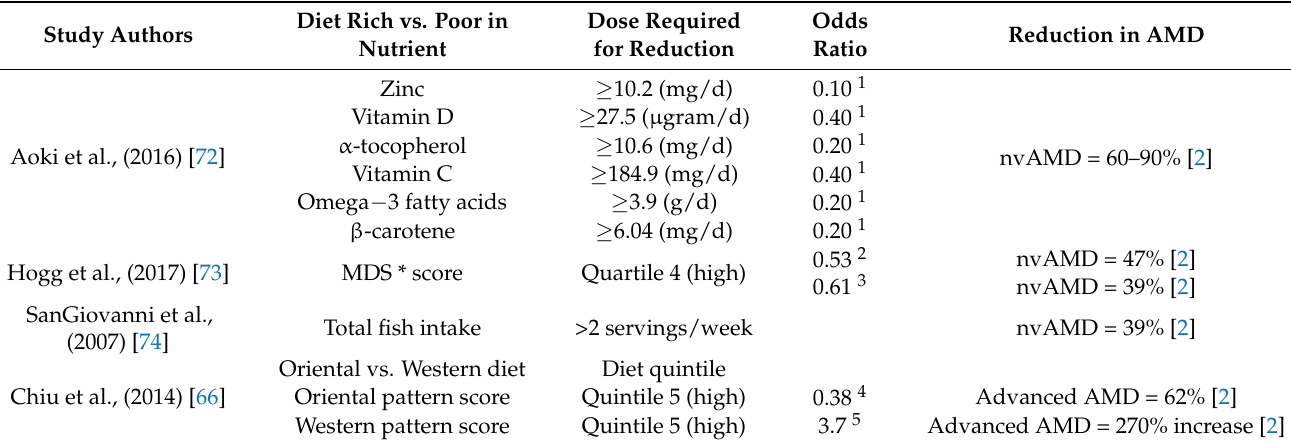
Table 4. Nutritional and dietary factors in